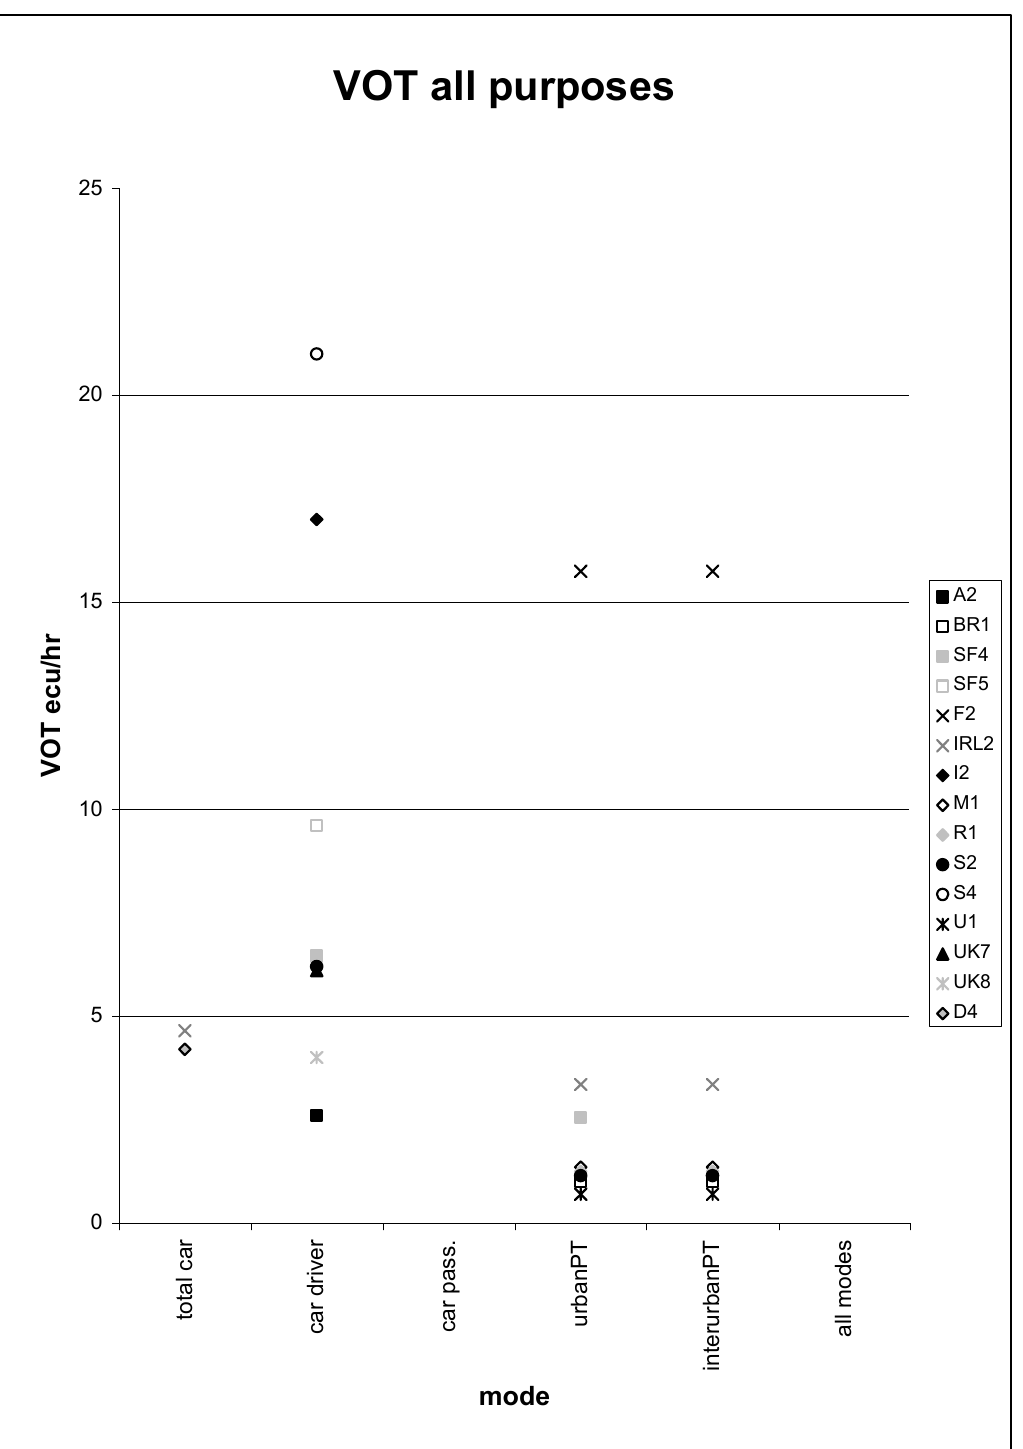
Figure 1: Value of Time Values for All Purposes from Different